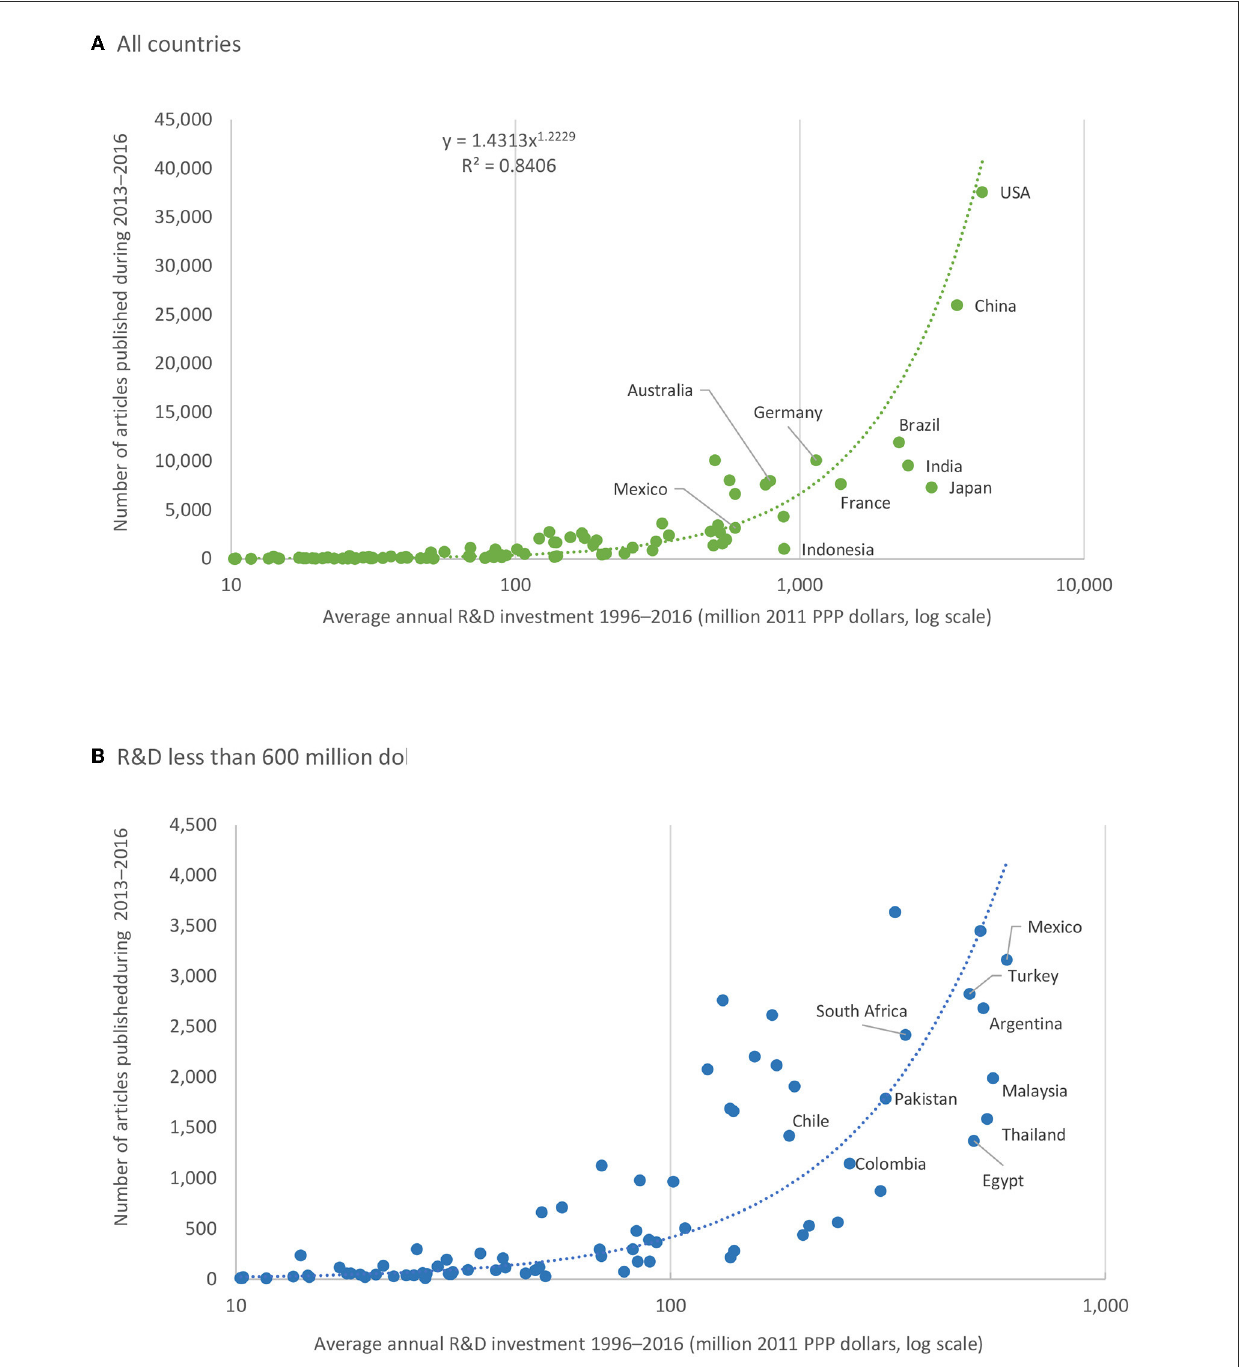
FIGURE7 Size of the agricultural research system measured in dollars of R&D spending vs. the number of scientific publications in agricultural and biological science. (A) All countries. (B) Countries investing less than 600 million. PPP$ in agricultural research. Sources: Elaborated by authors based on Agricultural Science and Technology Indicators (2022) and SCImago